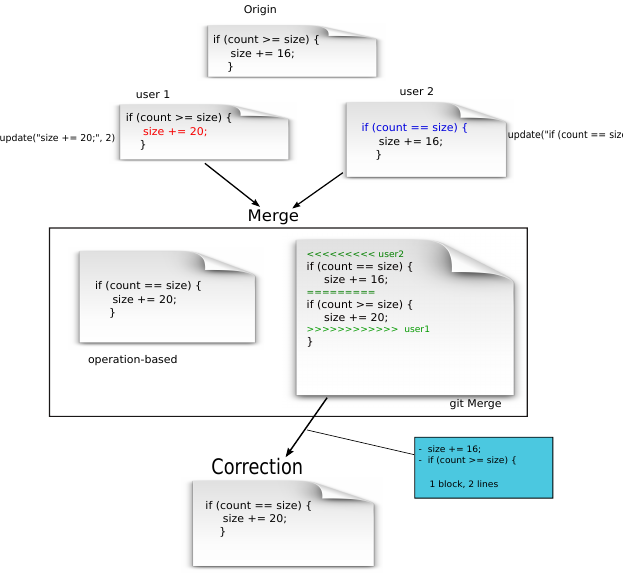
Figure 12. Concurrent consecutive modifications